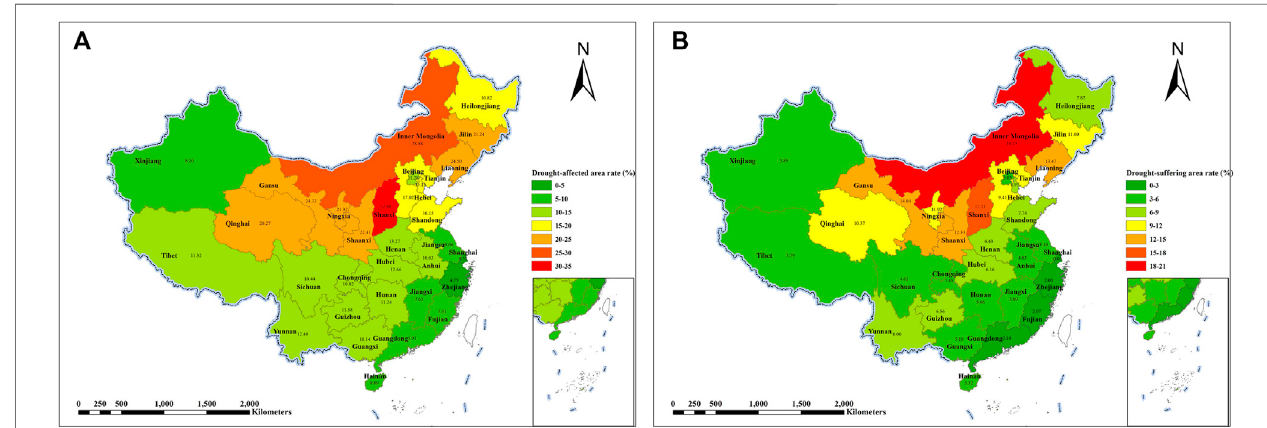
FIGURE 3 | Spatial distribution of multi-year average agricultural drought disasters. (A) Drought-affected area rate. (B) Drought-suffering area rate.